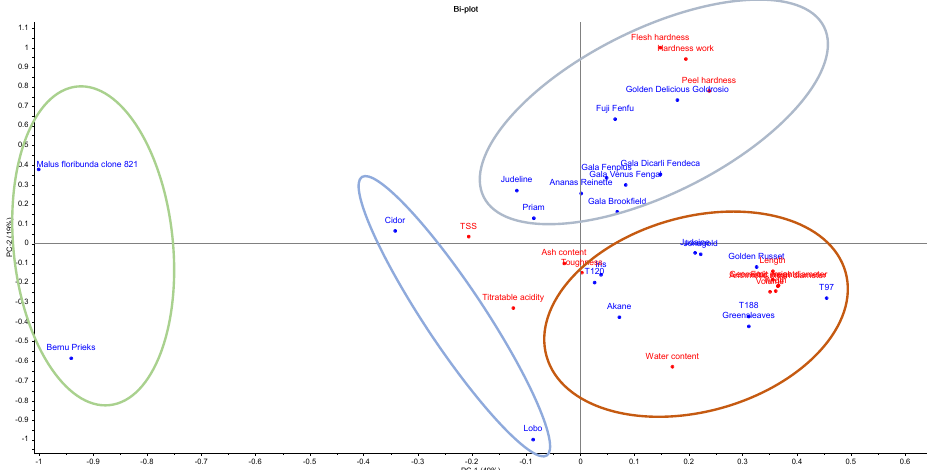
Figure 3. Principal component analysis (PCA) bi-plot for the 22 studied apple genotypes based on texture and physico-chemical quality attributes.